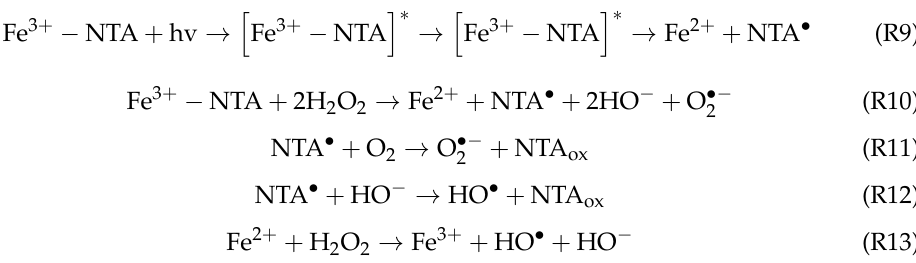
(Table 1), close to the results of the UVC-LED/S 2 O 82 − system—2.94 mM with 25 min,